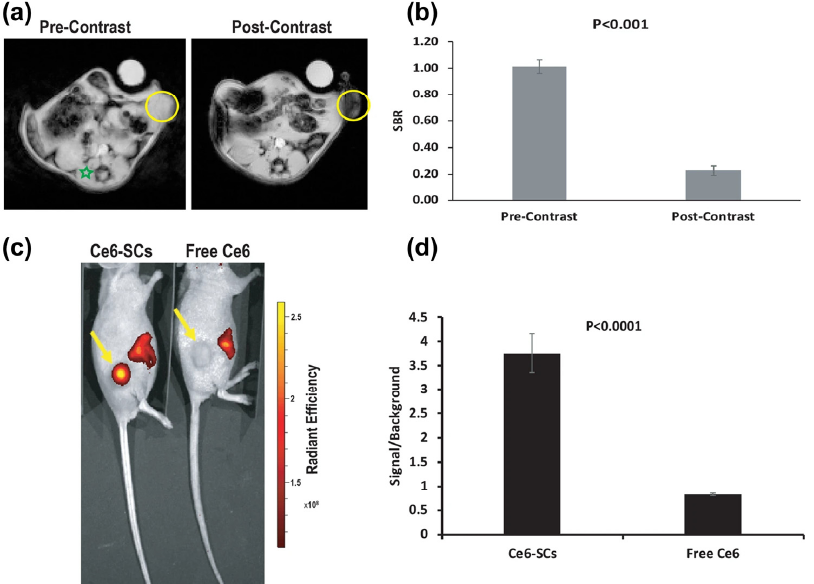
Figure 3. ( a ) In vivo magnetic resonance images (MRI) obtained pre- and 24 h post-intravenous injection of Ce6-SCs into mice bearing 4T1 flank tumors, denoted by yellow circles. ( b ) Quantification of the preinjection vs. postinjection signal-to-background ratio (SBR) measured using the candidate tumor and the paraspinous musculature (green star) background. ( c ) Fluorescence images (FIs) of mice acquired 24 h following injection of 2.5 mg/kg Ce6 based on the Ce6 weight of Ce6-SCs (left) and free Ce6 (right). ( d ) Signal-to-background ratio (SBR) of mice injected with Ce-SCs and free Ce6 at 640 and 720 nm excitation and emission, respectively. Reproduced with permission from reference [16].